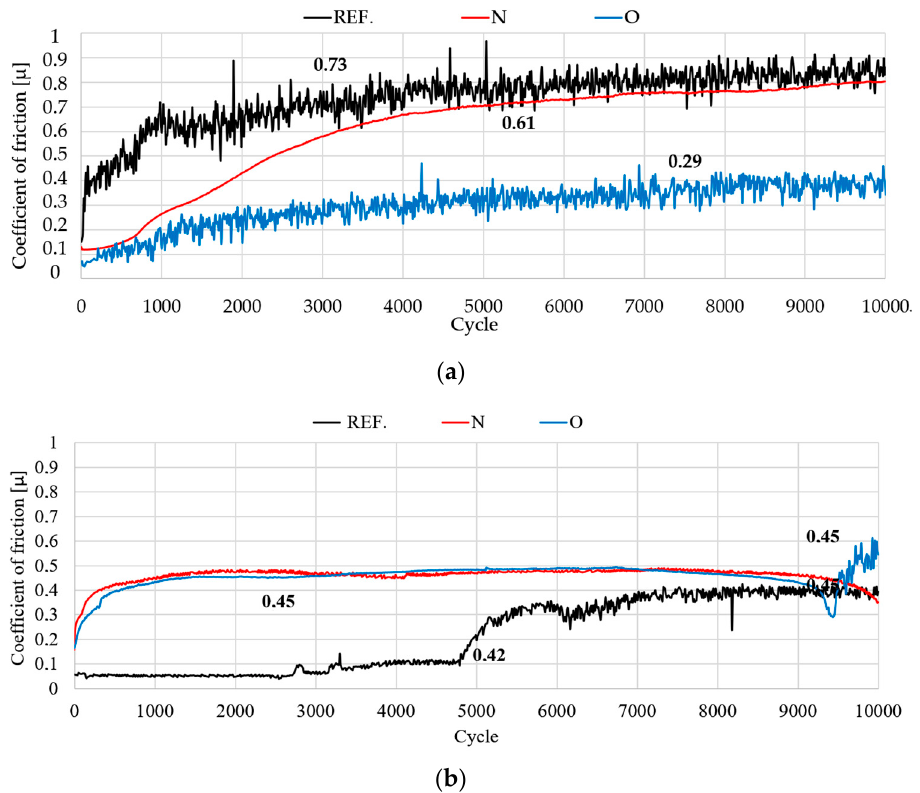
Figure 10. Average friction coefficient obtained ( a ) under dry friction (DF) and ( b ) with the use of Ringer’s solution (RS) as a lubricant.